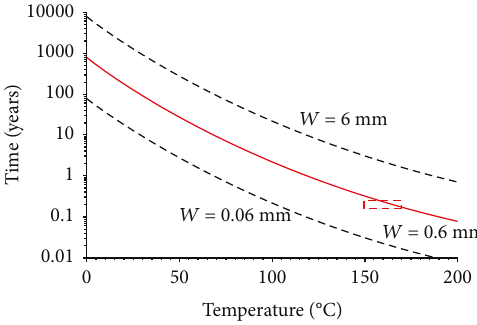
, with R and τ . This N